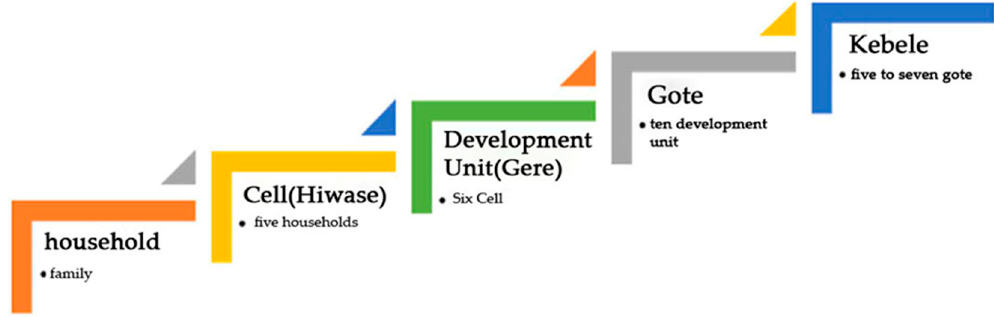
Figure 2. Local governance sub-administration structure; source: developed by authors.